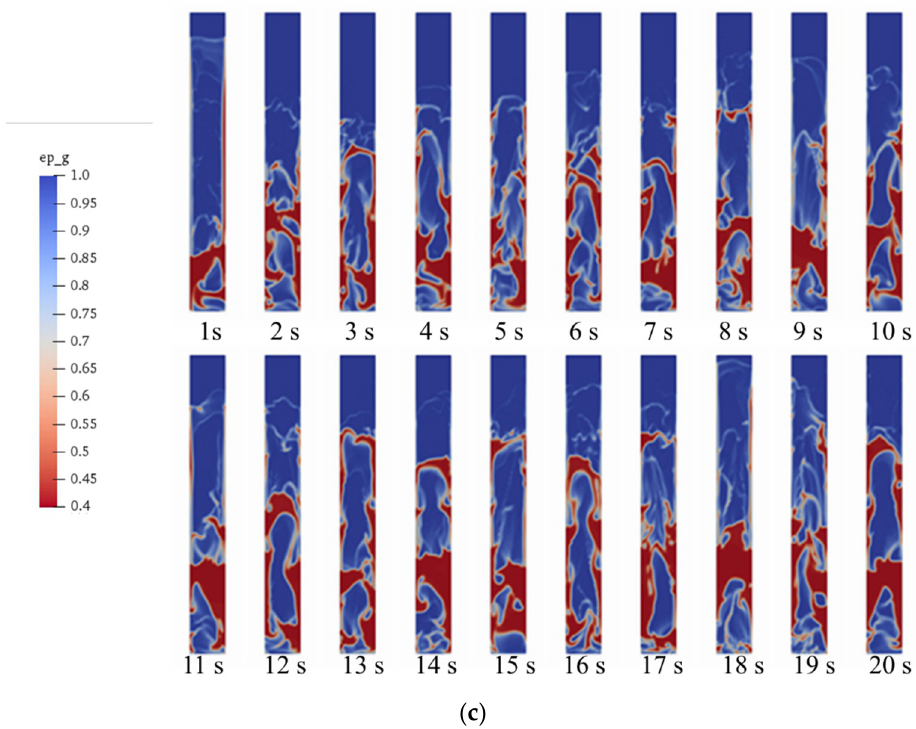
Figure 3. ( a ) Gas–solid flow field in gasifier (ER 0.2); ( b ) gas–solid flow field in gasifier (ER 0.3); ( c ) gas–solid flow field in gasifier (ER 0.4).